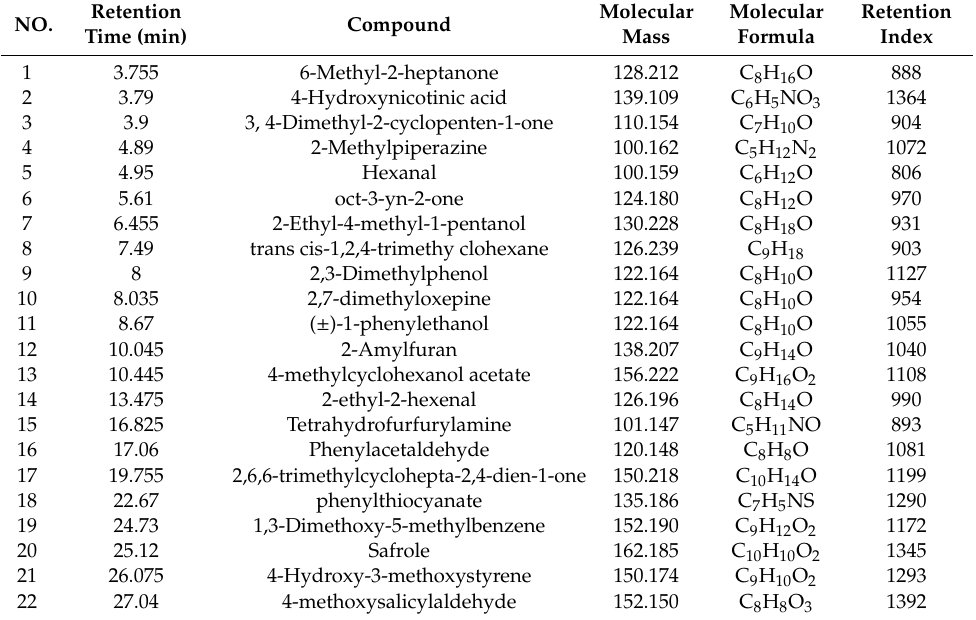
Table 5. Chemical markers identified, based on